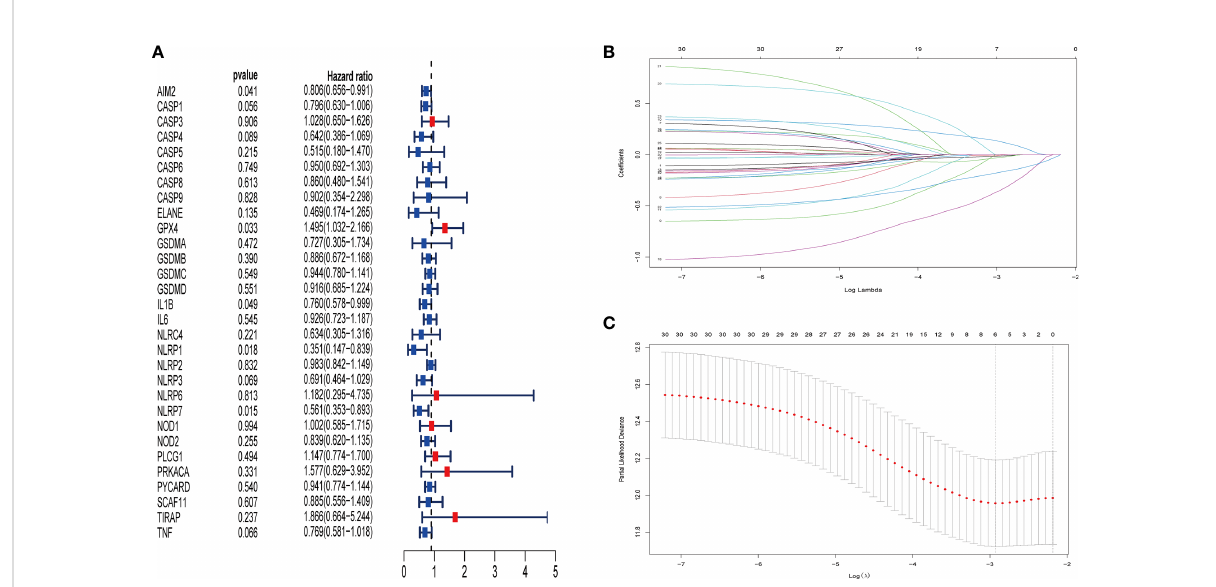
FIGURE 4 Identi fi cation of pyroptosis-associated genes in patients with TNBC with prognostic signi fi cance by univariate Cox regression analysis and LASSO Cox regression analysis. Thirty pyroptosis-associated genes were identi fi ed to be associated with prognosis in patients with TNBC via univariate Cox regression analysis (red point indicates HR value > 1, blue point indicates HR value< 1) (A) . LASSO coef fi cient pro fi les of 30 pyroptosis-associated genes with P< 0.01 (B) . The results of the fi vefold cross-validation determined the optimal value of the penalty parameter l ( l =0.05346444). Six independent prognostic genes for risk model construction were identi fi ed (C)